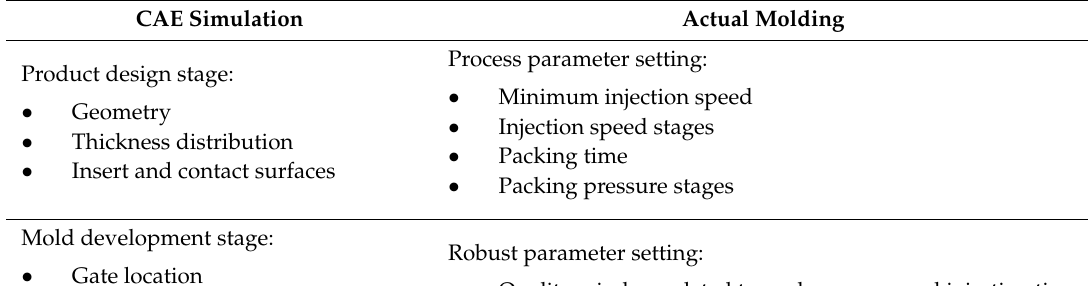
Table 1. Intelligent mold testing technique.